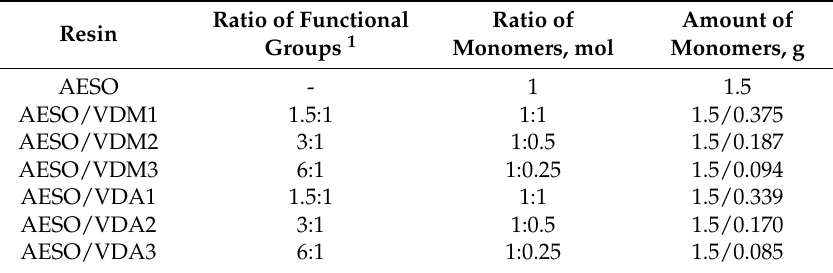
Table 1. The composition of resins.